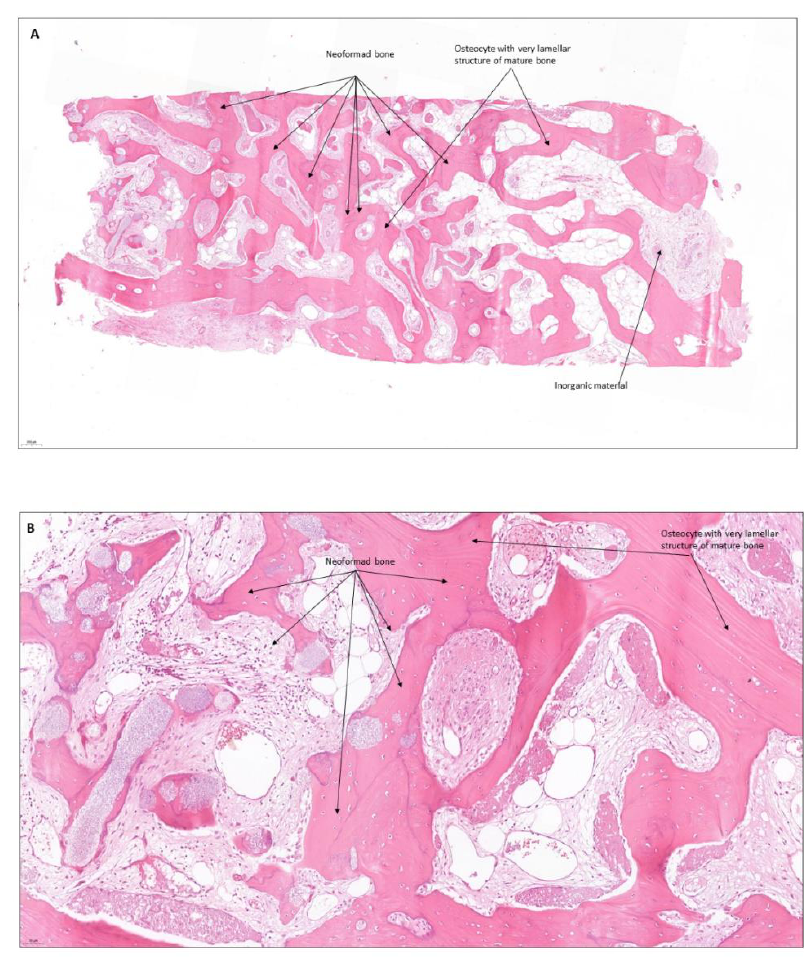
Figure 17. Few remains of inorganic material and abundant newly formed bone. ( A ) at 50 × and ( B ) at 200 × . Total bone length 6.63 mm, and clearly newformed bone indistinguishable from the rest 3.53 mm.